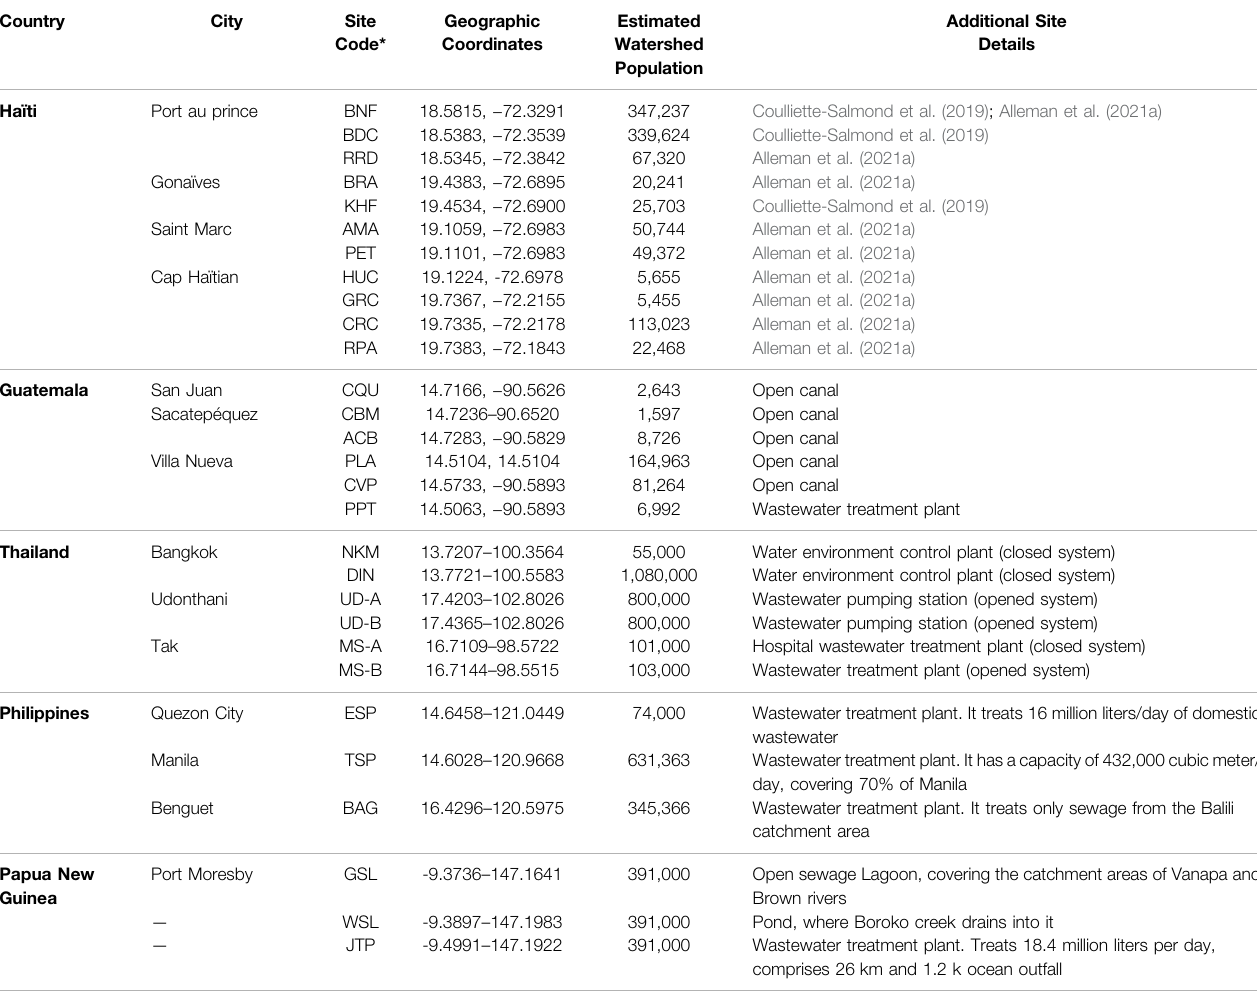
TABLE 1 | Poliovirus environmental surveillance sites used during the parallel and pilot testing. Country City Site